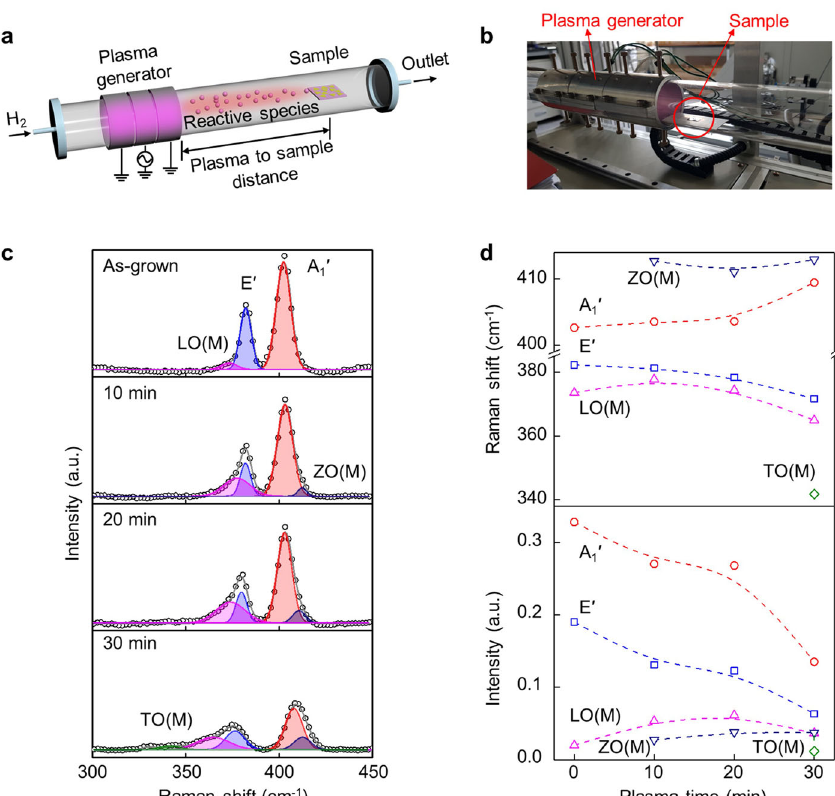
Fig. 1 Exposure of hydrogen plasma to MoS 2 using remote hydrogen plasma treatment system. Schematics ( a ) and photograph ( b ) of the home-built remote hydrogen plasma system. c Raman spectra fi tting result of MoS 2 and HP-MoS 2 . d The frequencies (top panel) and intensities (bottom panel) of E ′ , A 1 ′ , LO, ZO, and TO